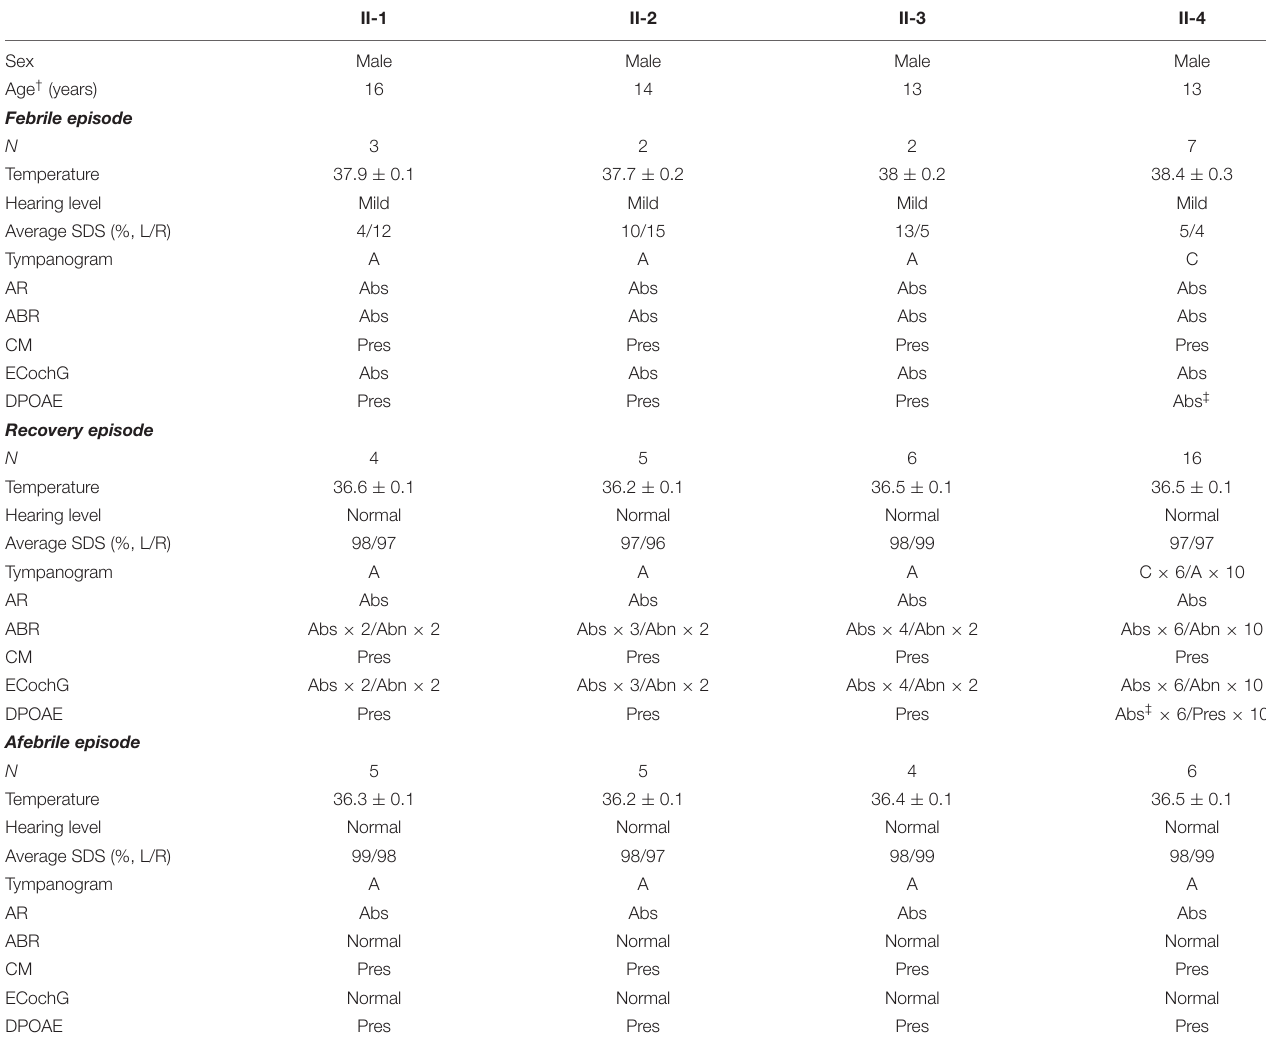
TABLE 2 | Clinical features of four brothers with temperature-sensitive auditory